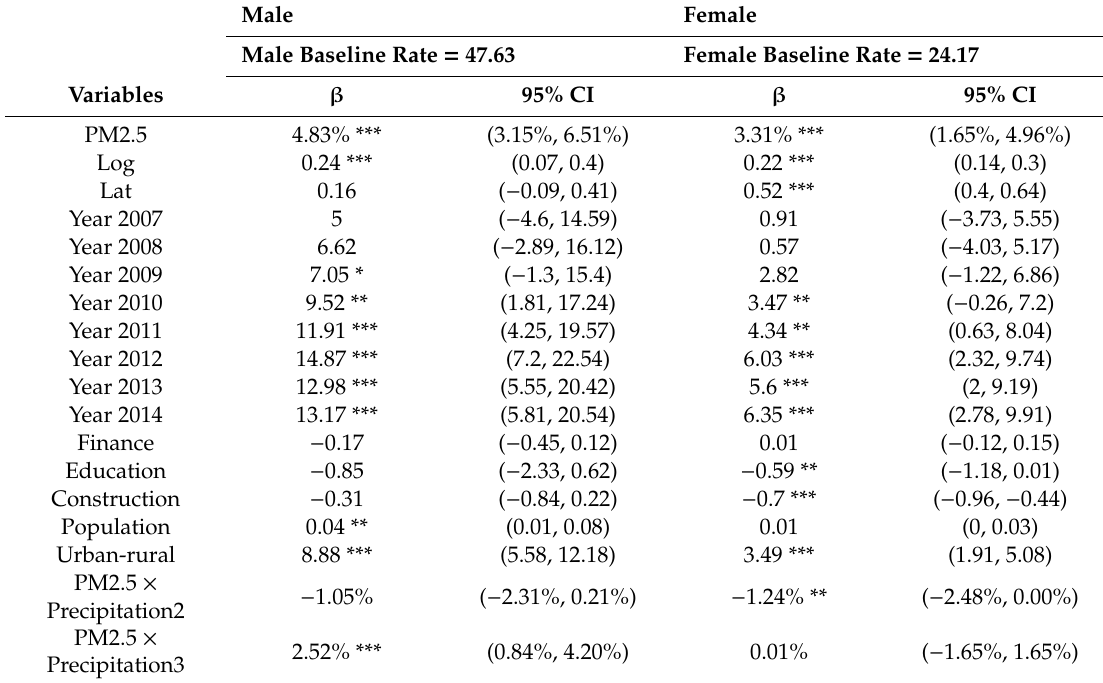
Table 9. Modification e ff ects of